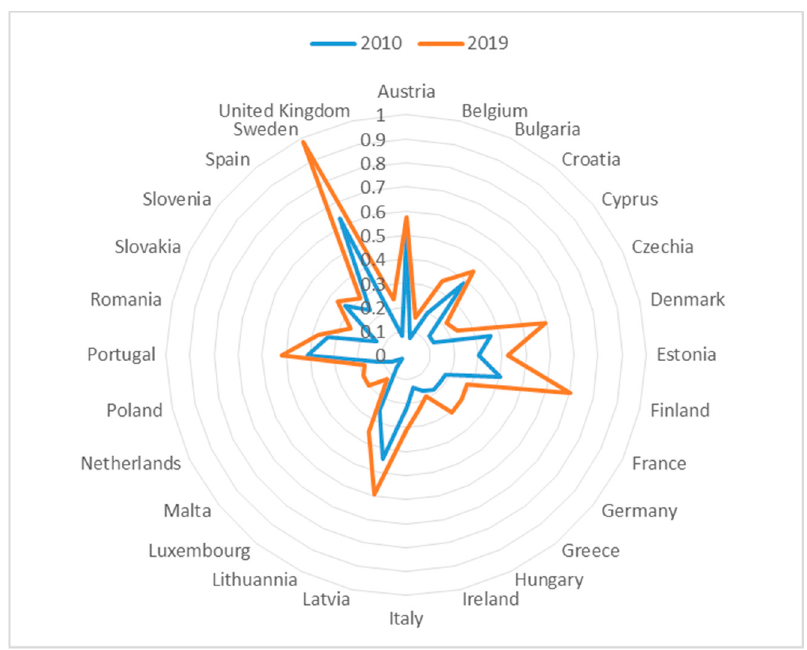
Figure 5. The average level of fulfilment of headline target 3 of Europa 2020 Strategy (Increasing the share of renewable energy sources in total energy consumption to 20 %.) in case of the EU28 in the years 2010 and 2019.